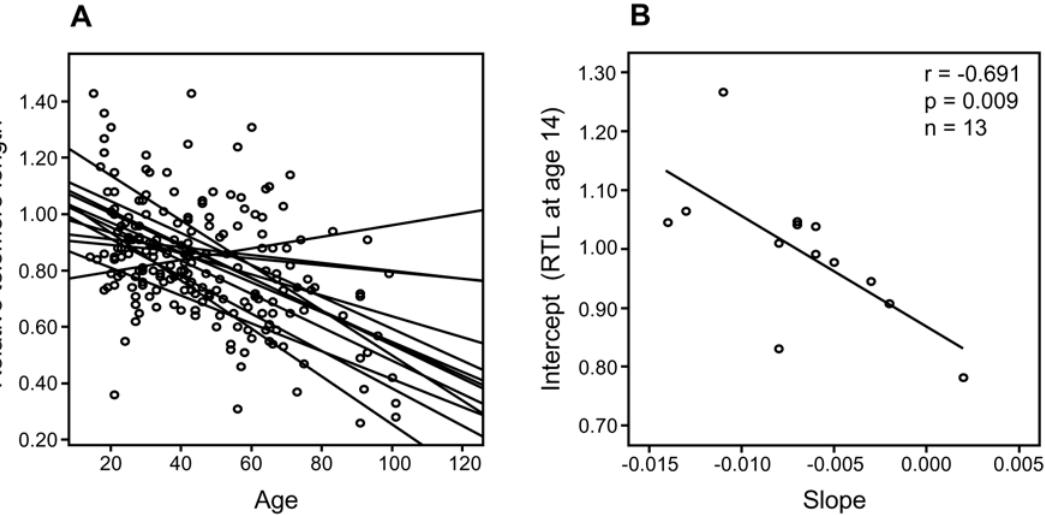
Figure 2. Correlation between RTL and attrition rate in 13 separate families. Each family contained 10 or more (maximum 28) related individuals (i.e., no in-laws). (A) Illustration of telomere shortening with age in 13 individual families. The separate regression lines were obtained by plotting RTL vs. age for each individual in a family. (B) Telomere attrition rate (i.e. slope) in the 13 families in relation to the estimated RTL at age 14 in each family, showing a strong negative correlation.